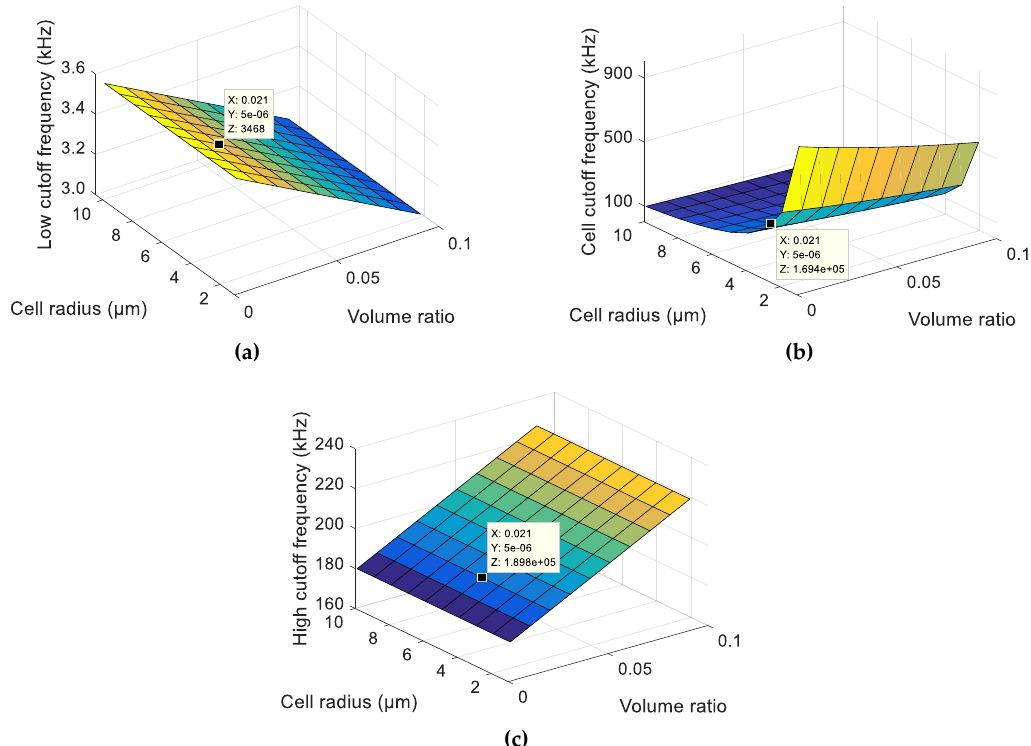
Figure 5. ( a ) Low cutoff frequency; ( b ) cell cutoff frequency; and ( c ) high cutoff frequency in the function of the volume ratio (ratio of the cell volume / measurement volume) and cell radius from the analytical model.